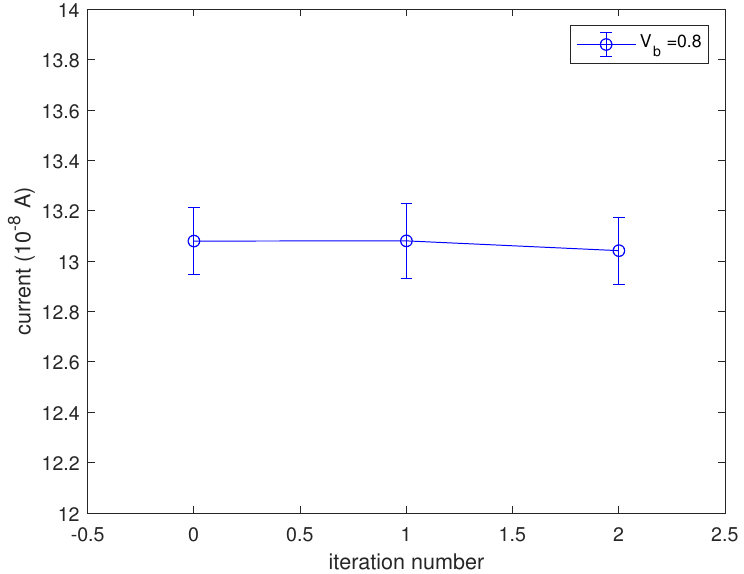
Figure 8. The current versus iteration number, for V b = 0.8